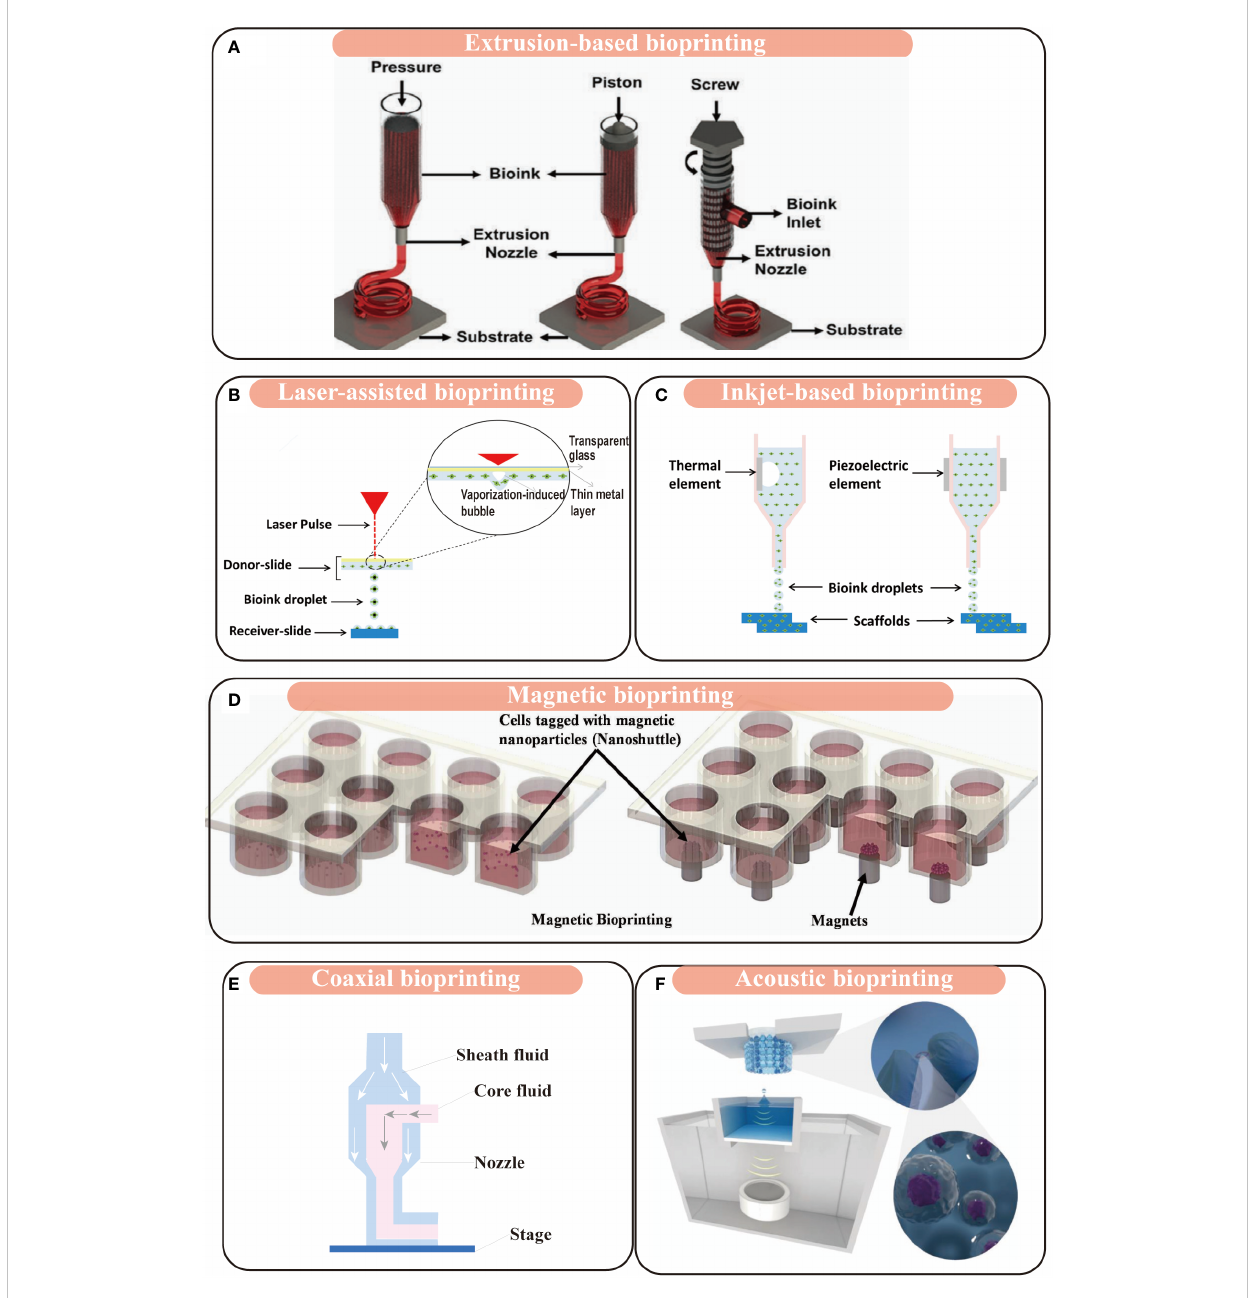
FIGURE 1 Schematic fi gures of 3D bioprinting modalities. (A) Extrusion-based bioprinting; adapted with permission (18), copyright 2019 John Wiley and Sons. (B) Laser-assisted bioprinting; adapted with permission (49), copyright 2018, MDPI (open access). (C) Inkjet-based bioprinting; adapted with permission (49), copyright 2018, MDPI (open access). (D) Magnetic bioprinting; adapted with permission (21), copyright 2020 ELSEVIER. (E) Coaxial bioprinting. (F) Acoustic bioprinting; adapted with permission (47), copyright 2021 John Wiley and Sons (open